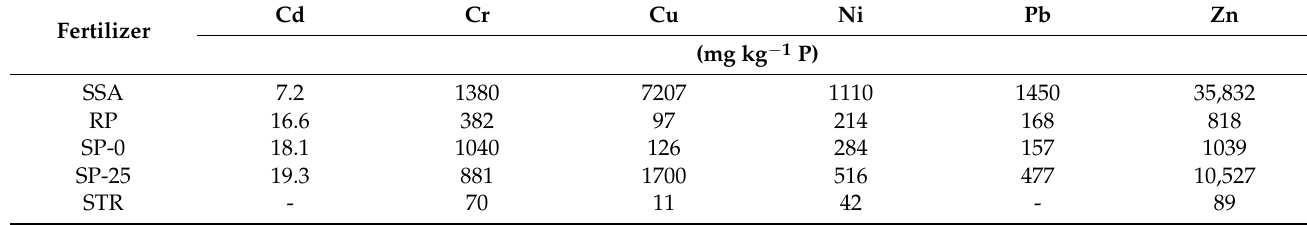
Table 3. Calculated mean input of the elements cadmium (Cd), chromium (Cr), copper (Cu), nickel (Ni), lead (Pb), and zinc (Zn) per kg phosphorus (P) (mg kg − 1 P). For fertilizer abbreviations, see Table 1. Fertilizer